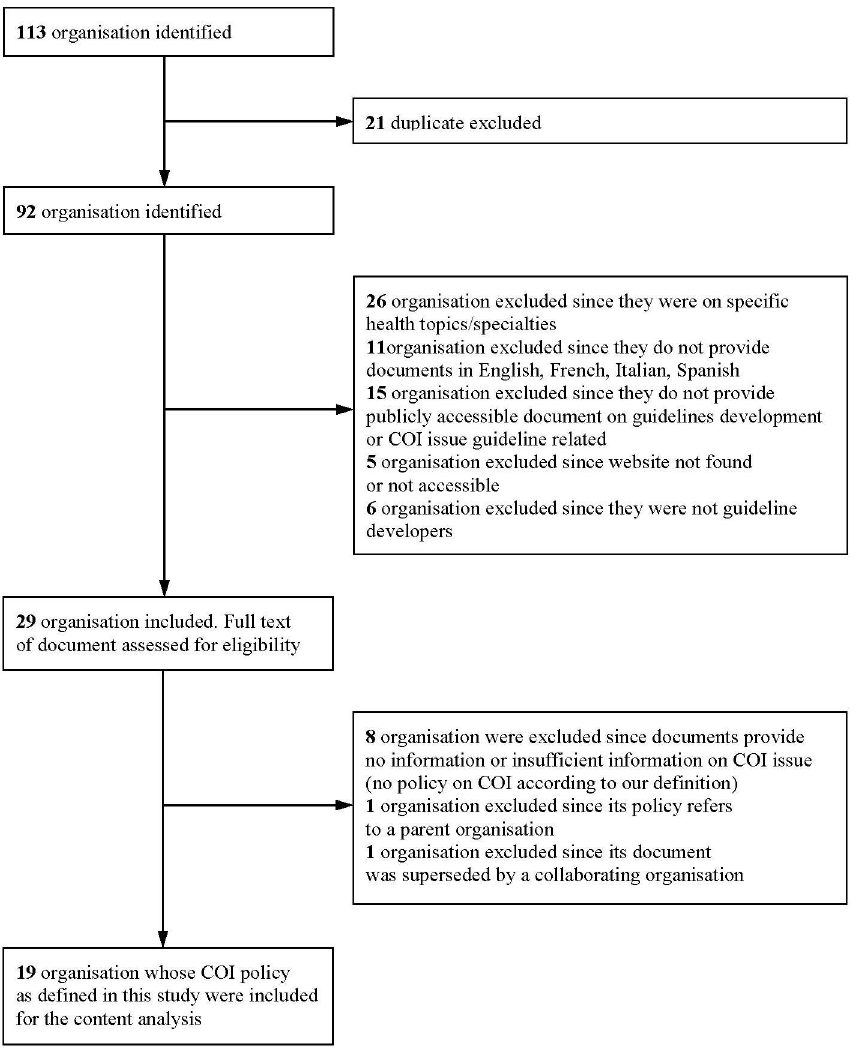
Fig 1. Organisation identification and inclusion